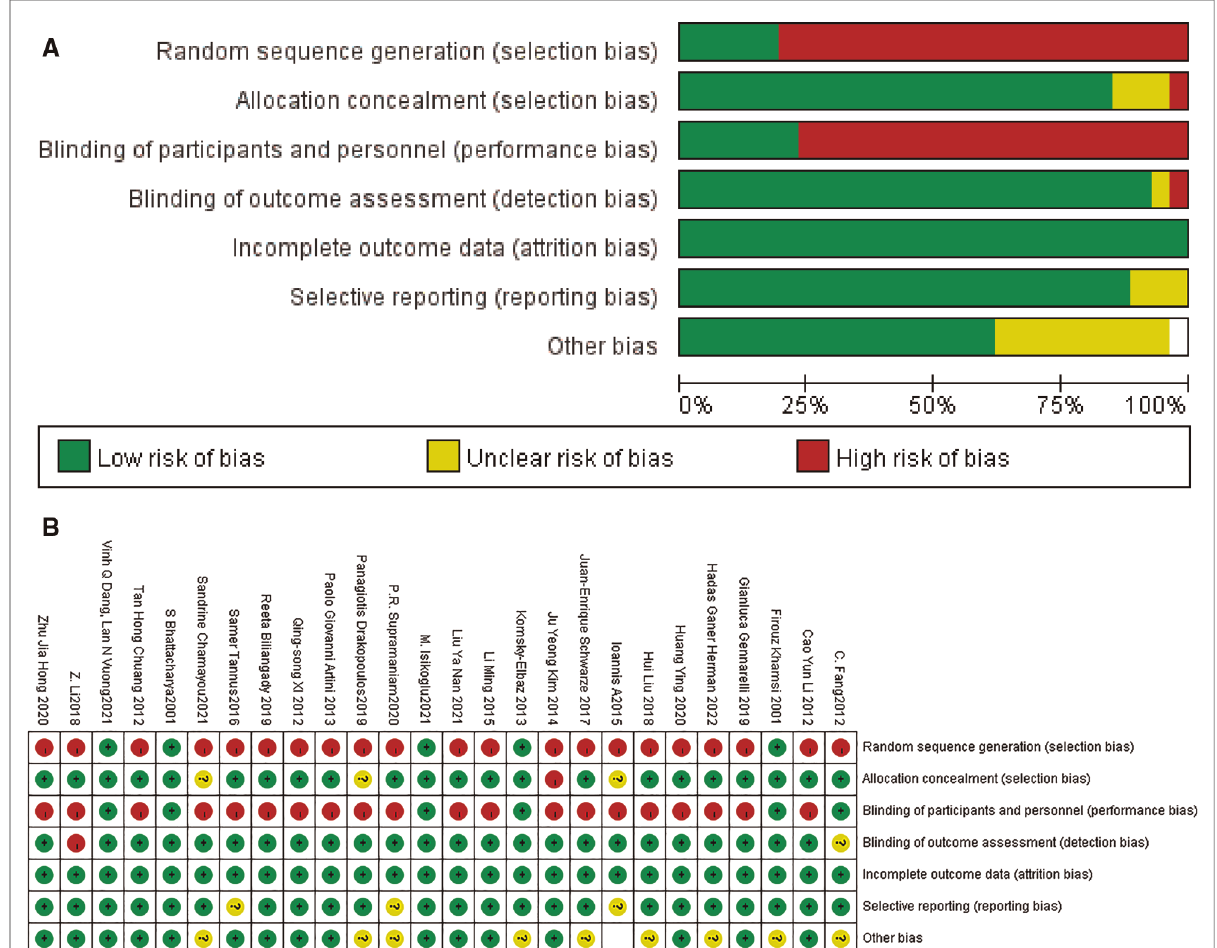
FIGURE 2 Low risk of bias, Unclear risk of bias, and High risk of bias were determined based on 1. whether there was random sequence generation 2. whether an allocation concealment scheme was implemented 3. whether blinding of patients, trial personnel, and outcome assessment was implemented 4. whether outcome data were complete 5. whether there was selective reporting 6. whether there was another